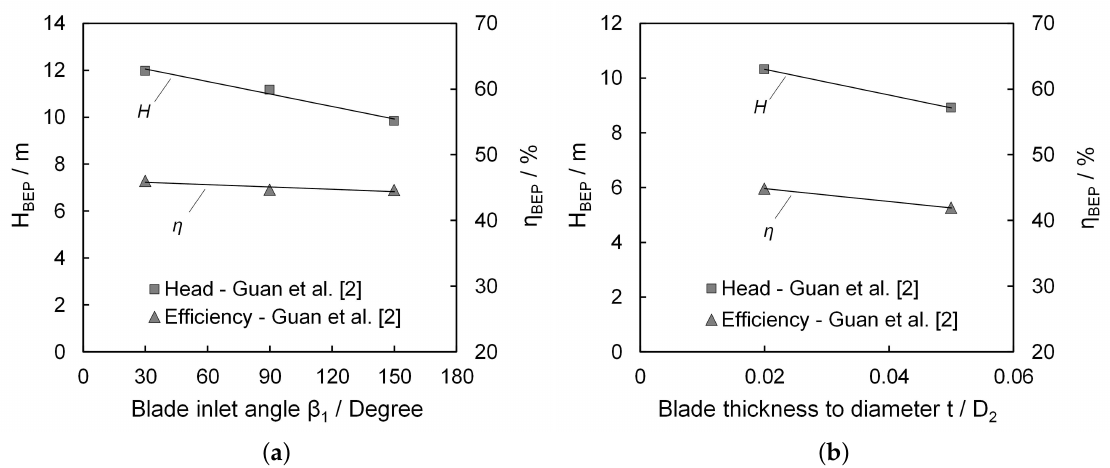
Figure 14. ( a ) Head and efficiency over blade inlet angle; and ( b ) head and efficiency over blade thickness to impeller